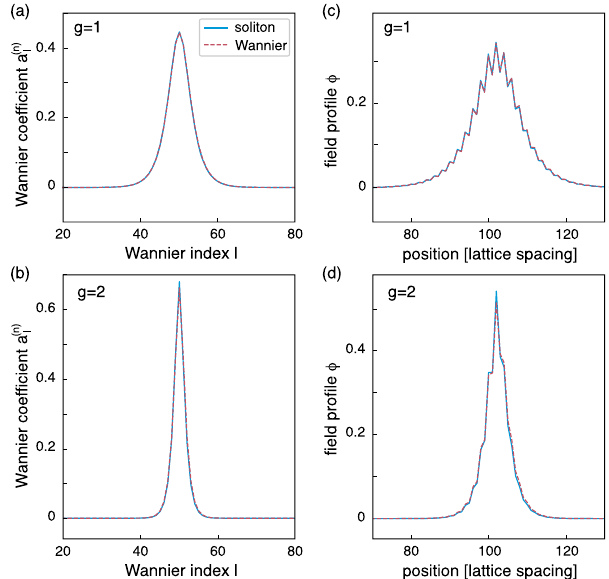
Fig. 2 | Numerical validation of the simpli fi ed theoretical scheme. a , b Wannier representation of a soliton in the lowest band ( n =0) of the nonlinear Rice-Mele model (blue solid line), compared with the soliton obtained from the simpli fi ed DNLS Eq. (7) (dashed red line), for g = J 0 and g =2 J 0 and time s =0.12. Here, J 0 is a characteristic hopping strength (Methods). Note how increasing the nonlinearity further localizes the soliton. c , d Same comparison in real